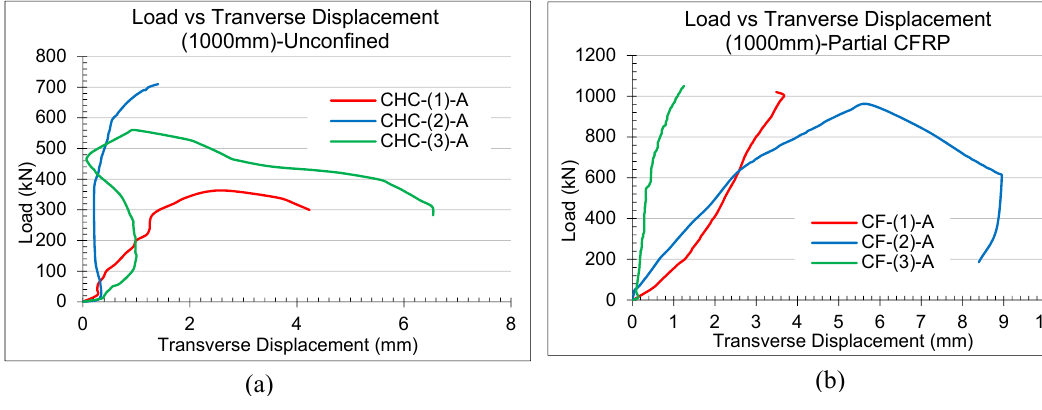
Figure 5. Load vs Tranverse Displacement; (a) Unconfined CHRCC (b) Partial CFRP CHRCC.